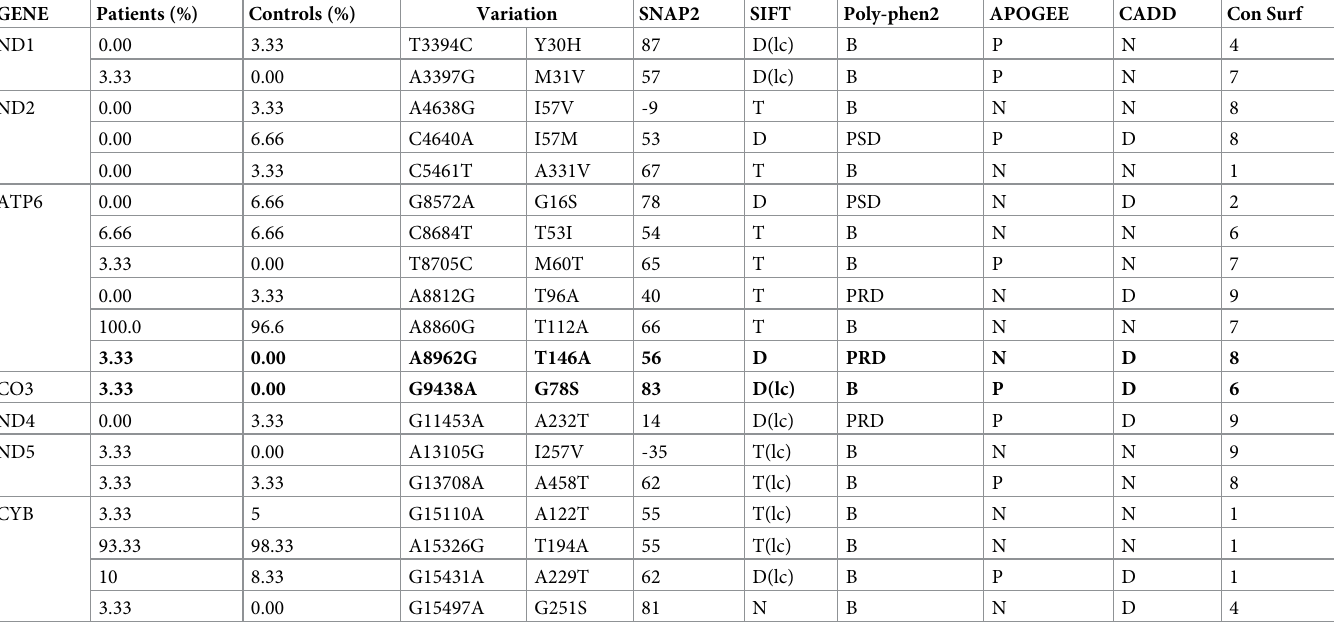
Table 1. Missense variants predicted to be deleterious by in silico analyses. Only the variants with SNAP2 score > 50 or ConSurf conservations score > 8 are shown. (see S5 Table for complete list of missense variations) a B: Benign, D: deleterious, lc: low confidence, N: neutral; P: pathogenic; PRD: probably damaging, PSD: possibly damaging, T: tolerated, U: unknown. Variants subjected to molecular dynamic simulations are given in